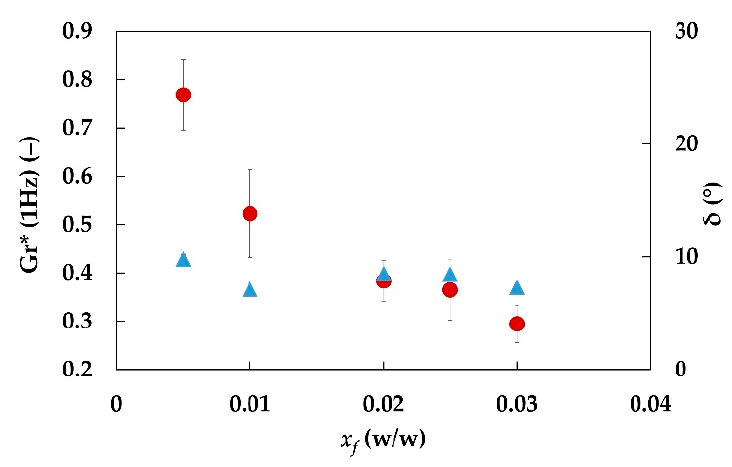
Figure 6. Relative complex modulus G ∗ r (1 Hz) (red circles) and phase angle δ (1 Hz) (blue triangles) of emulgels with 20% w/w of oil phase, at different fiber fraction and constant preparation conditions (E2.3.y.20 samples). Operating energy and power of mixing for emulgels and aqueous suspensions: E s = 45.2 J/g and P s = 0.151 W/g.